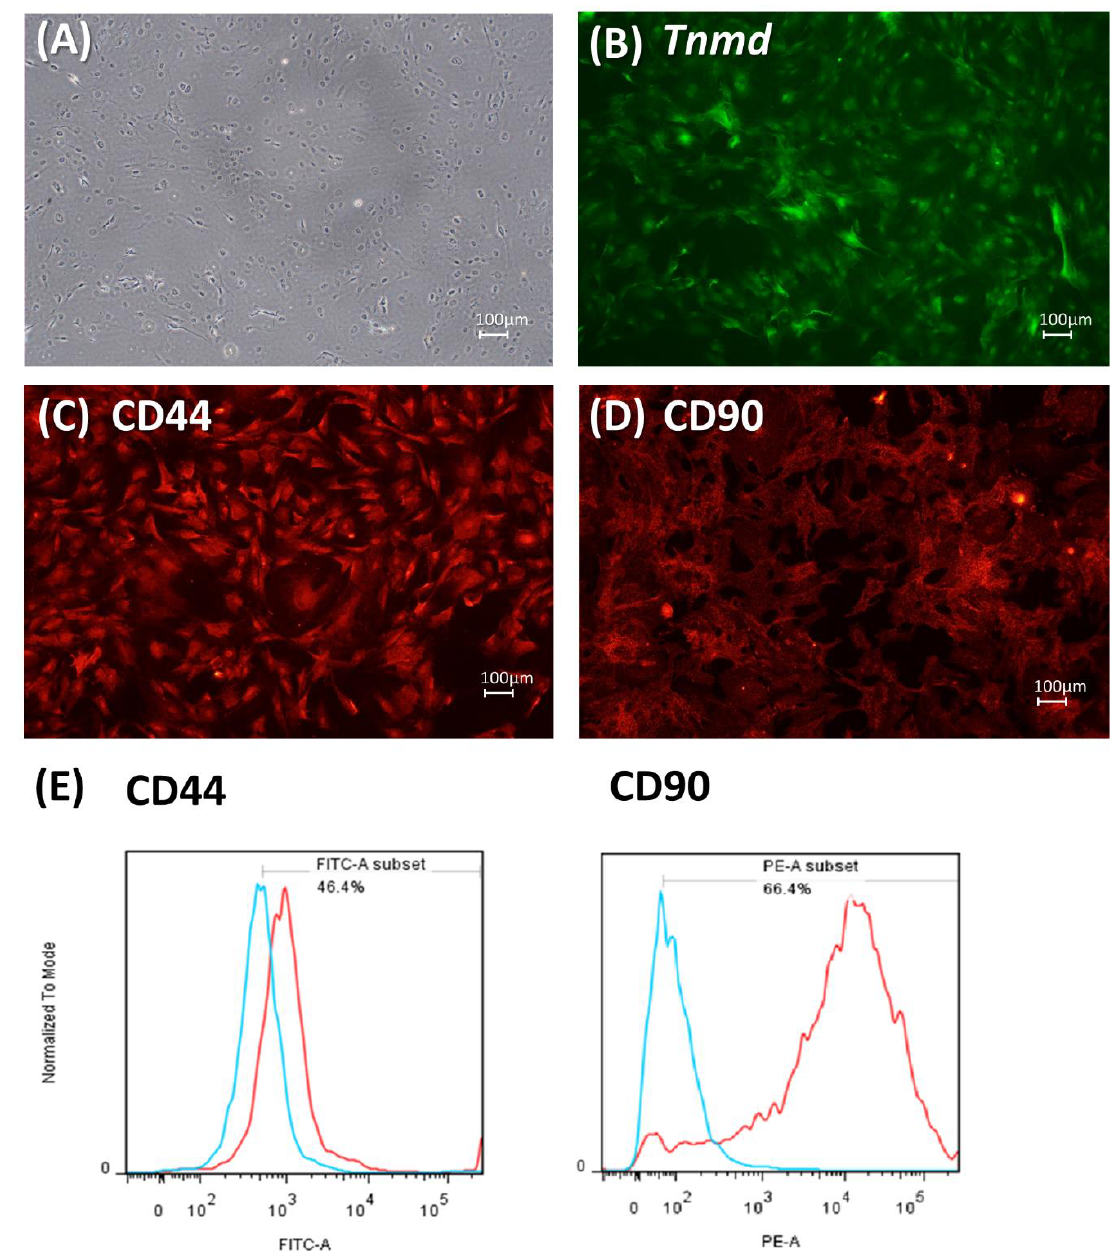
Figure 1. Characteristics of tendon-derived cells (TDCs). Representative photomicrographs (10 × ) of TDCs after extraction and 7 d of culture ( A ). Immunohistochemistry of tenomodulin ( Tnmd ) ( B ), CD44 ( C ), and CD90 ( D ). ( E ) Flow cytometry assay of the TDCs. The cells expressed CD 44 and CD 90, which are surface markers representing mesenchymal stem cells. Red lines: TDCs stained with CD 44 or CD 90; blue lines: TDCs stained with isotype-matched IgG1 as a negative control.